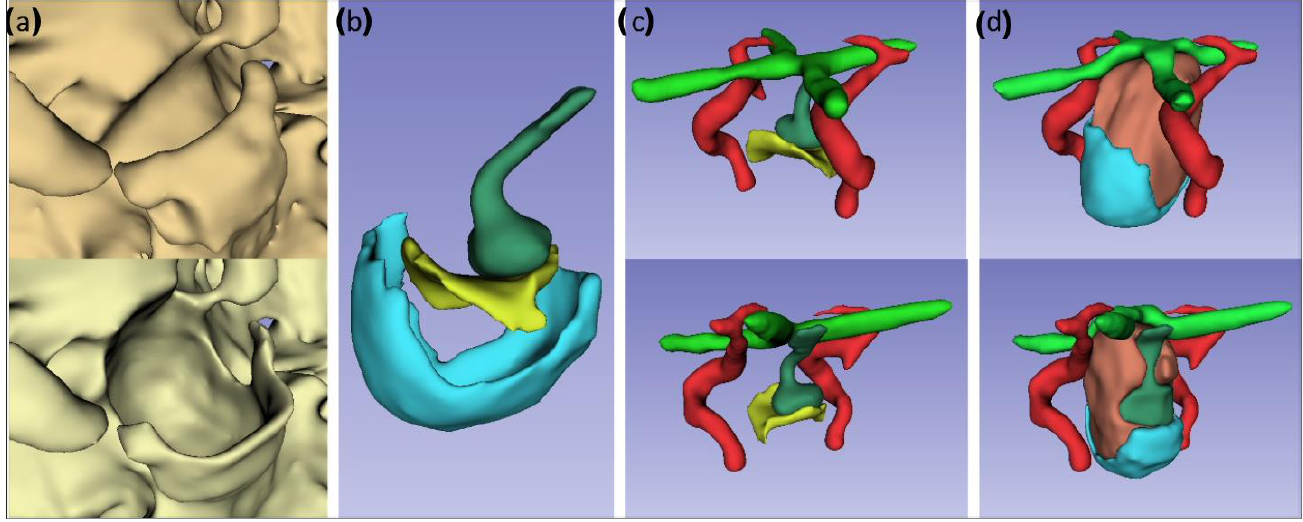
Figure 1. Modifications of the computational model of the cadaveric model. ( a ) Comparison between the original anatomy (top) and the pathological shape of the skull base (bottom). ( b ) Comparison of the original (yellow) and enlarged (turquoise) floor of the sella turcica. The original anatomy of the pituitary gland is presented in dark green. ( c ) Anterior and posterior view of the original anatomy of the sella turcica (yellow), internal carotid arteries (red), optic chiasm (light green), and pituitary gland (dark green). ( d ) Anterior and posterior view of the modified computational model of a pathological condition resulting from a pituitary tumor (coral) with an enlarged sella turcica (turquoise), a compressed pituitary gland (dark green), and a superiorly dislocated optic chiasm (light